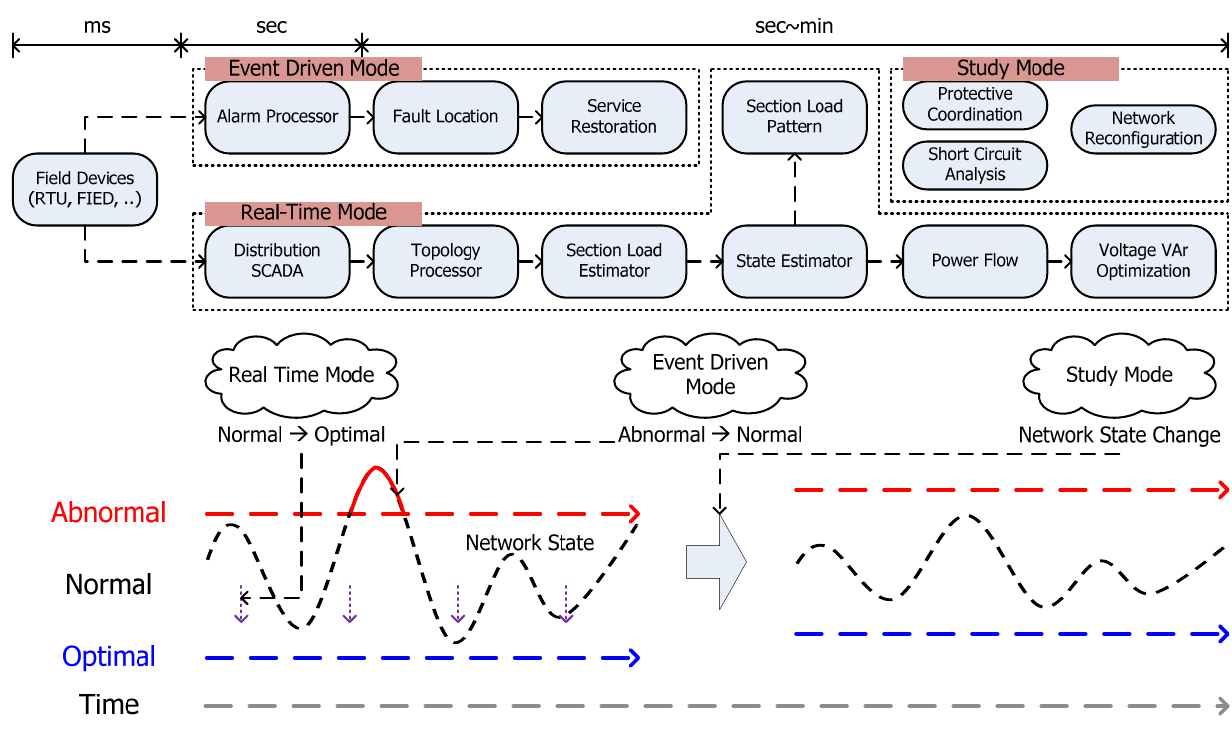
Figure 3. Structure for solution deduction in KSDMS